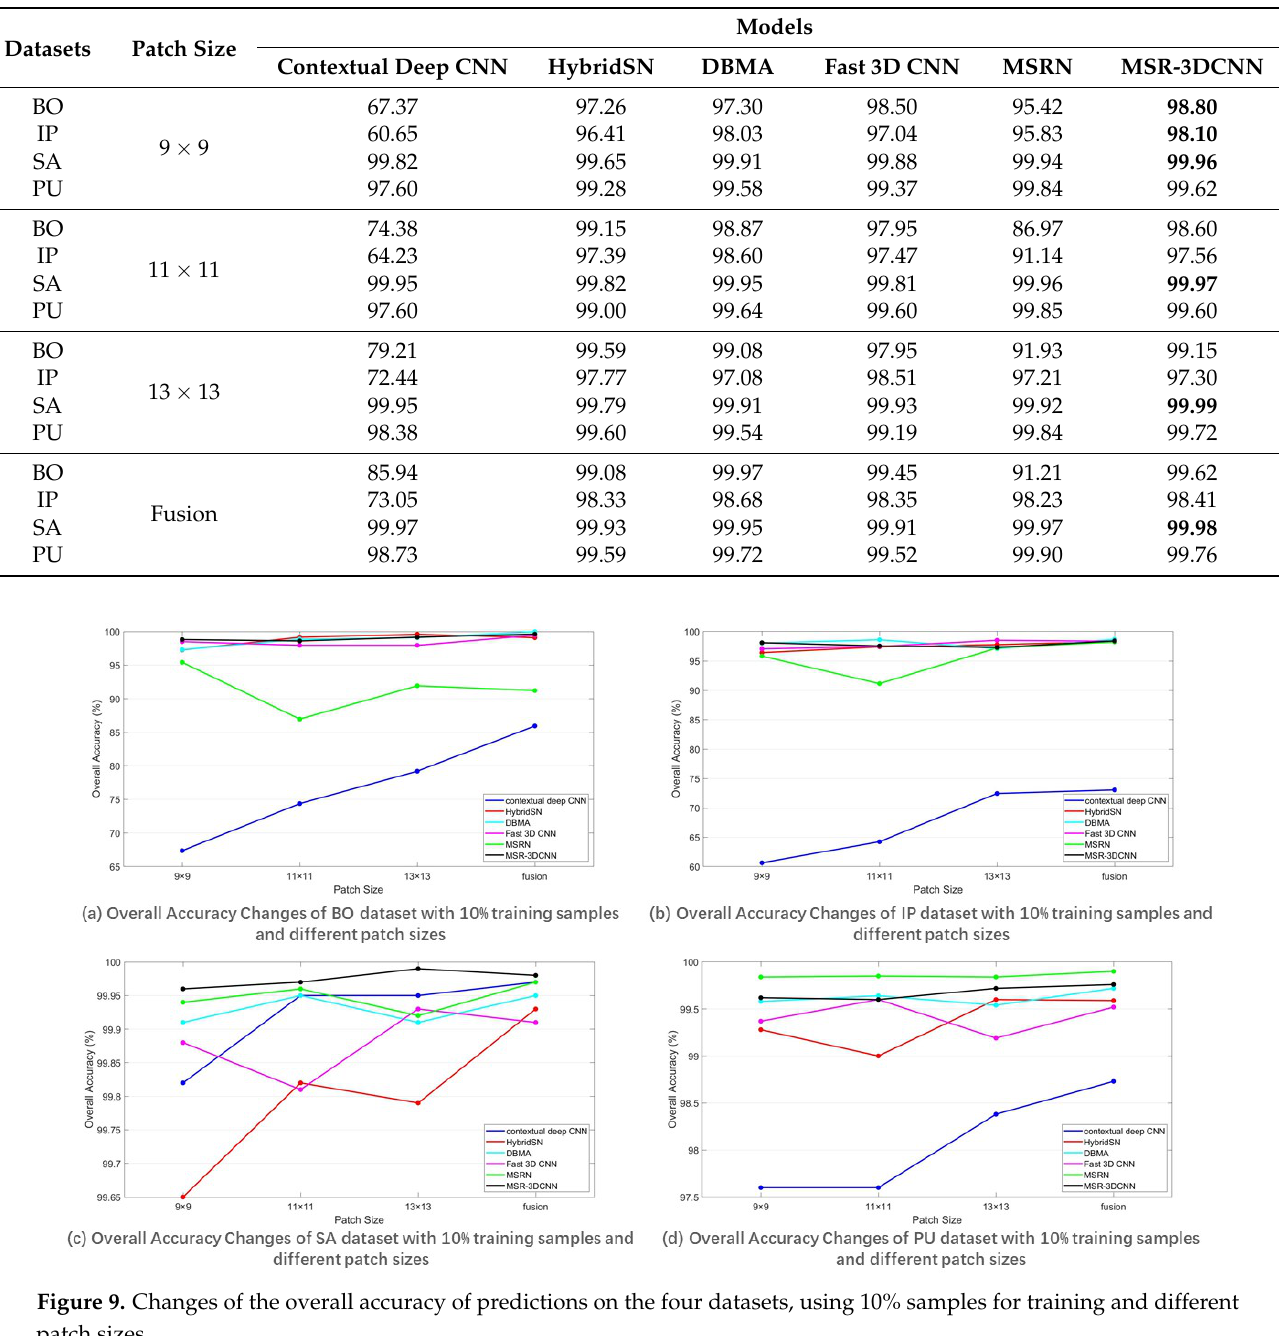
Table 2. Overall Accuracy (%) of the predictions by contextual deep CNN, HybridSN, DBMA, Fast 3D CNN, MSRN, and MSR-3DCNN using different patch size and the fuse the prediction results of these predictions obtained by sum rule.